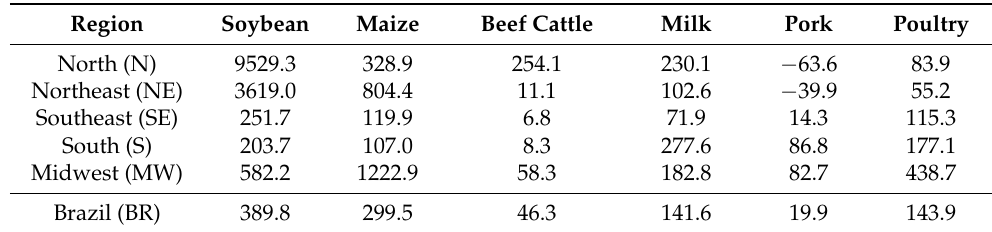
Table 1. Percent change in the production of selected agricultural and animal products, Brazil and regions, 2015/1990 ( ∆